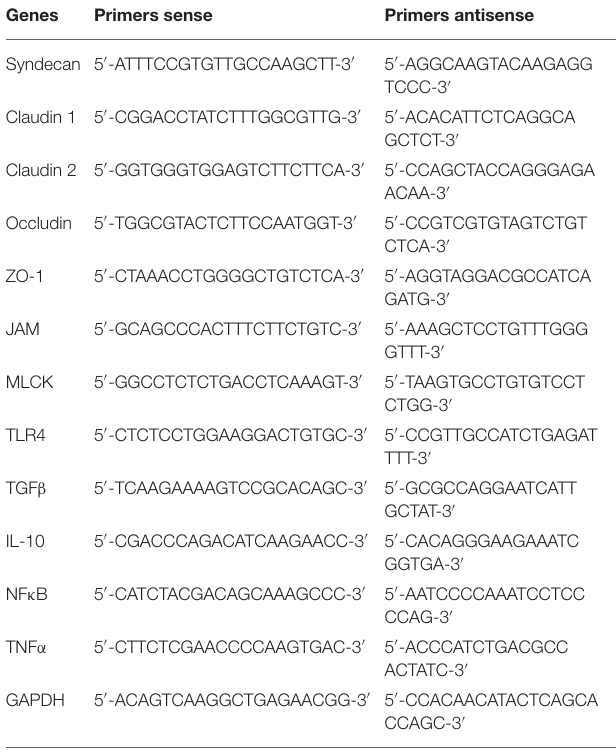
TABLE 2 | Sense and antisense primers sequences.